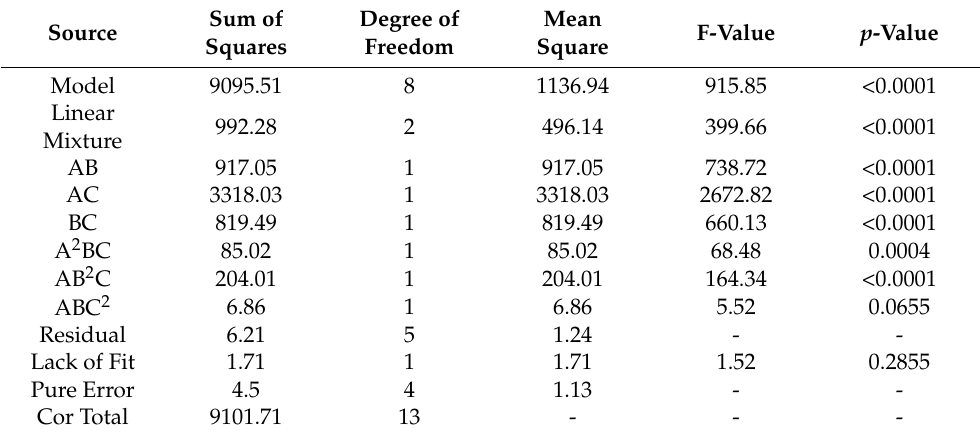
Table 2. Results showing outcomes of ANOVA test for the dependent variables